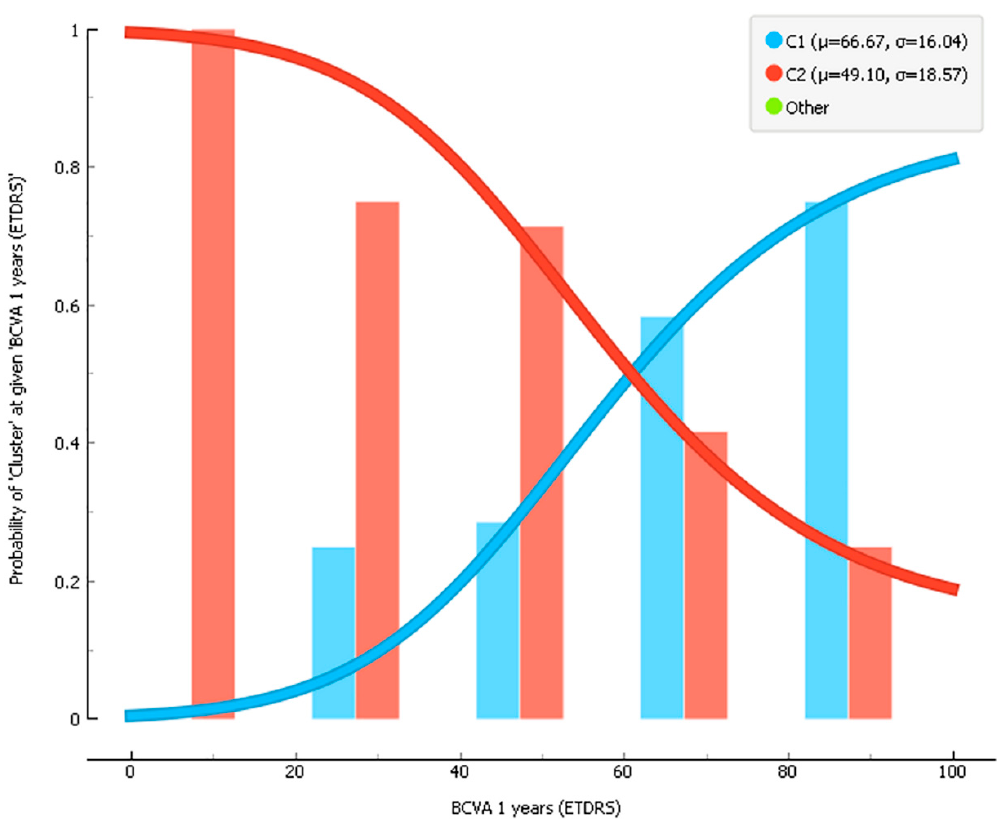
Figure 9. Probability belonging to a deep learning C1 or C2 given the BCVA value after 1 year. It shows that for C1 the probability increases with the increase in the BCVA value while the opposite is true for C2 since it contains all the lower BVCA values at 1 year. The green point shows that deep learning detects only the two clusters considered C1 and C2 and not others.